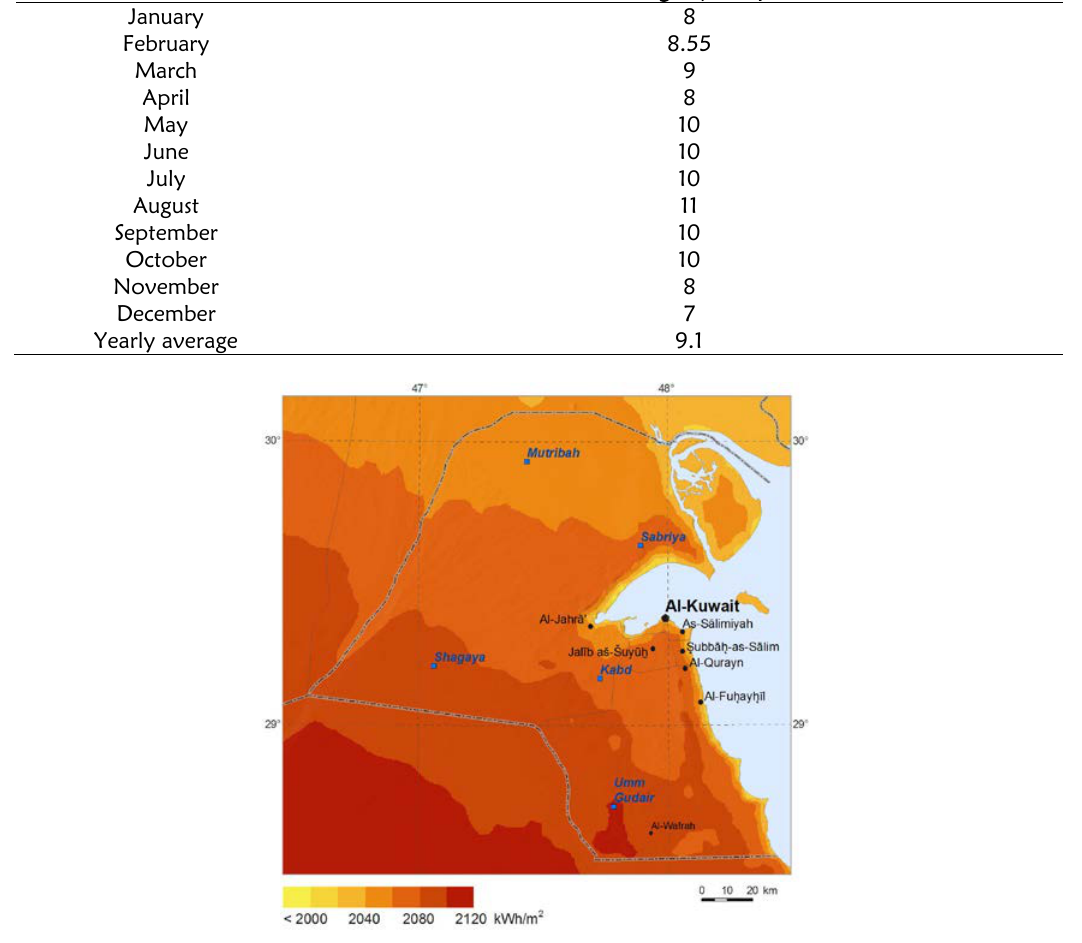
Figure 5: Shagaya on Kuwait solar